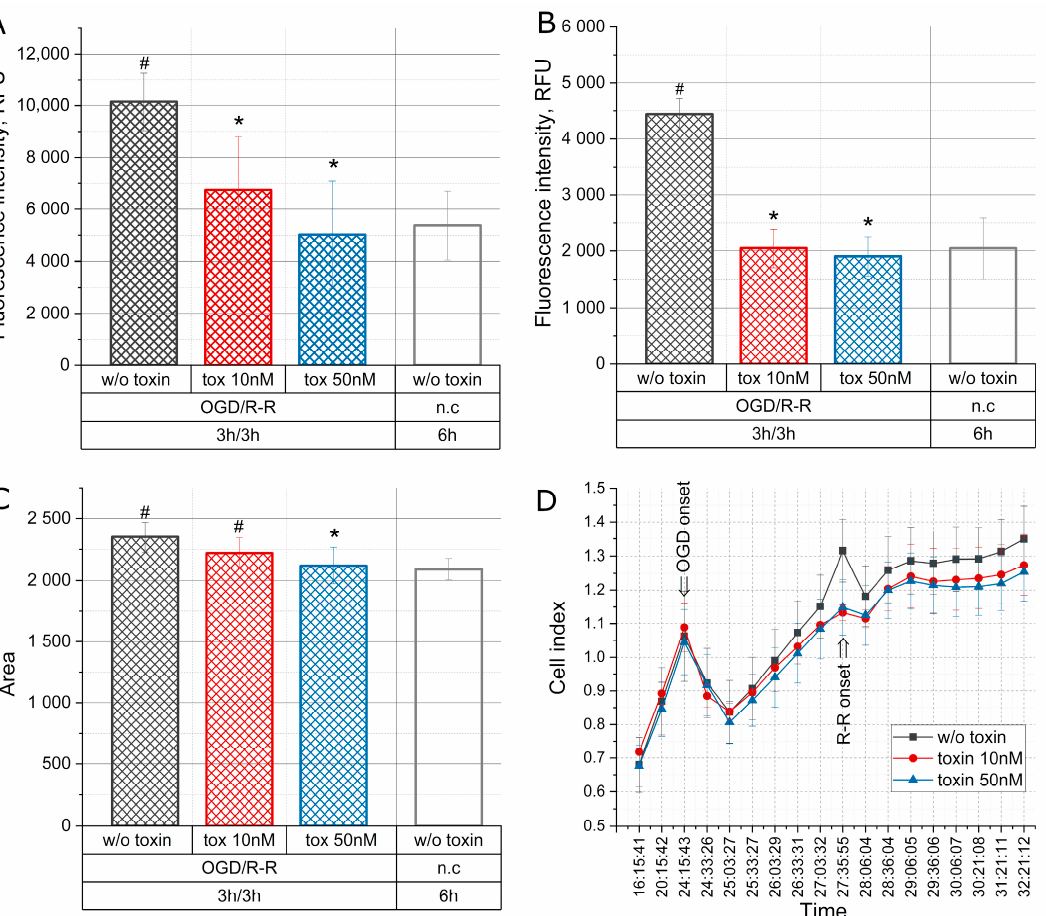
Figure 2. Change in the level of apoptosis ( A ), necrosis ( B ), cell area ( C ), and cell index ( D ) in the CHO-K1 culture with the toxin e ff ect at concentrations of 10 n М and 50 n М under conditions of OGD/R-R (OGD—oxygen–glucose deprivation, R-R—reoxygenation-reperfusion; n.c.—normal condition); RFU—relative fl uorescence units); *— p < 0.01 when compared with the “OGD w/o toxin” group, #— p < 0.01 when compared with the “n.c.” group.